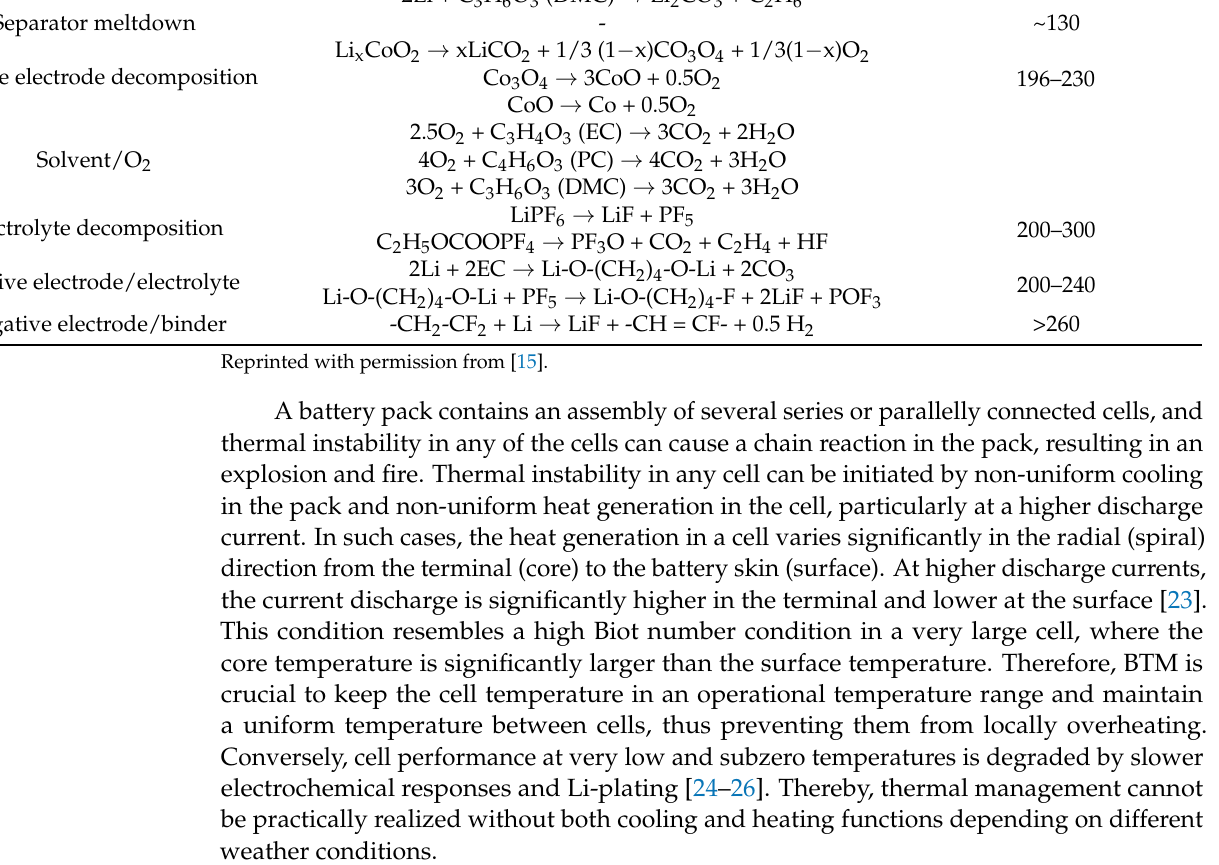
Table 1. Reactions relevant to Li-on battery thermal runaway [15,16] .